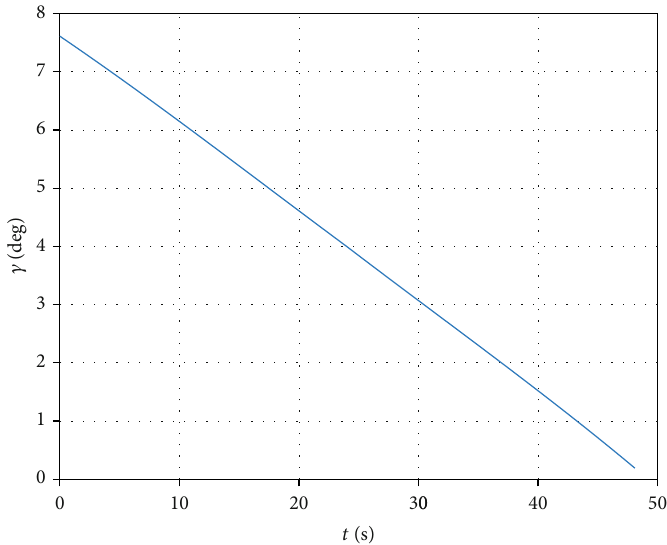
Figure 5: Time history of the fl ight path angle.